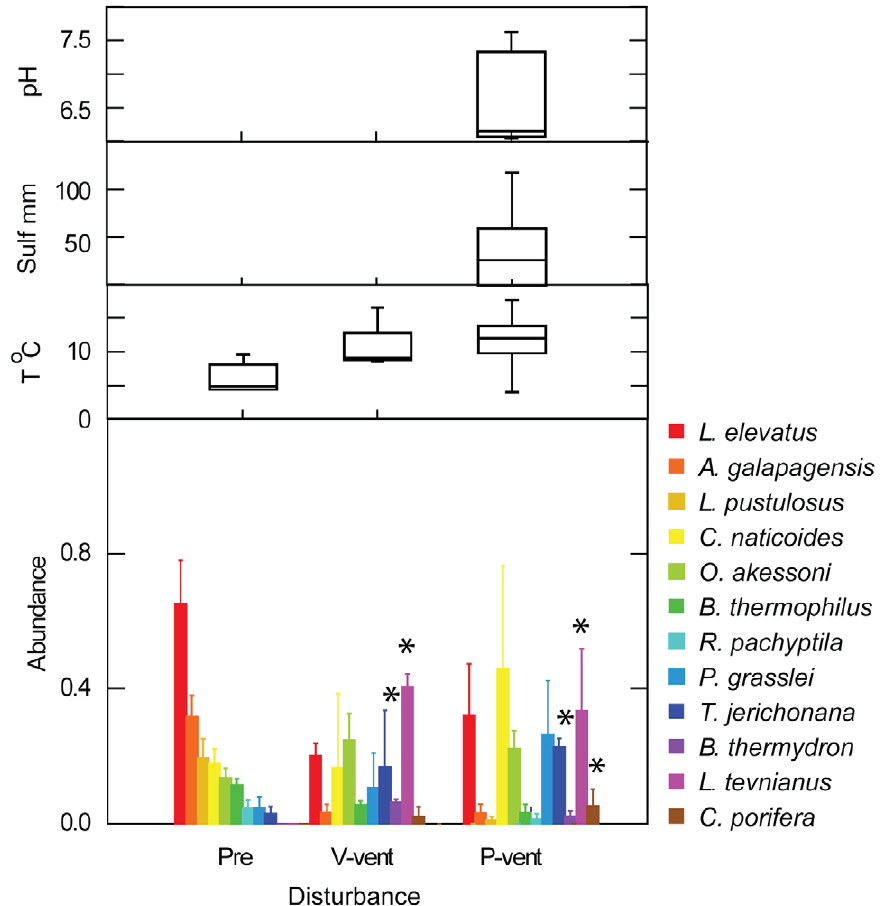
Figure 6. Variation of fauna and fluid environment with disturbance history at P-vent, V-vent and pre-eruption. Species abundance (mean and standard error; arcsine square-root transform of relative abundance) of selected species in pre-eruption samples in 9 u 50 9 N region (Pre) and in 22-month, post-eruption samples at P- and V-vents, all in hot habitat. Asterisk denotes abundance significantly greater than at least one other condition in ANOVA (Table S3) or Kruskal Wallace test. Environmental conditions, displayed as box plots (median, quartiles, range) measured in vicinity of colonization surfaces with Alvin T-probe alone (Pre-eruption and V-vent) or in combination with electrochemical sensors coupled with T- probes